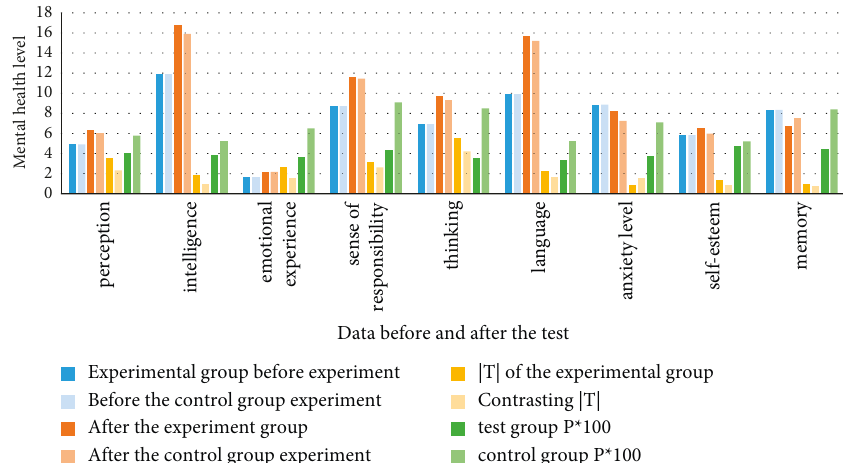
Figure 9: Comparative analysis of children’s mental health level between experimental group and control group before and after the experiment.